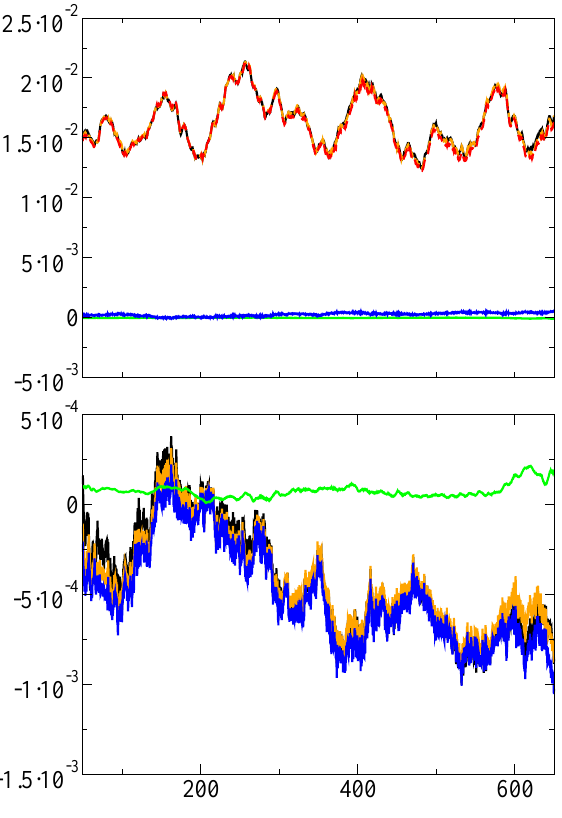
Fig. 7. Time evolution of the total r.h.s. and of the detailed contri- butions to the non-gyrotropic pressure in the equation for µ ⊥ (top) and µ k (bottom) for one of the runs presented in the top panel of Fig. 4, i.e., β = 0 . 075 and d i /l f = 1 . 27. Black: total r.h.s.; orange: sum of all the non-gyrotropic pressure contributions; red: term in- volving tr ( 5 i ·∇ u i ) s ; green: term involving ( 5 i ·∇ u i ) s : τ ; blue: term involving 5 i : d τ dt